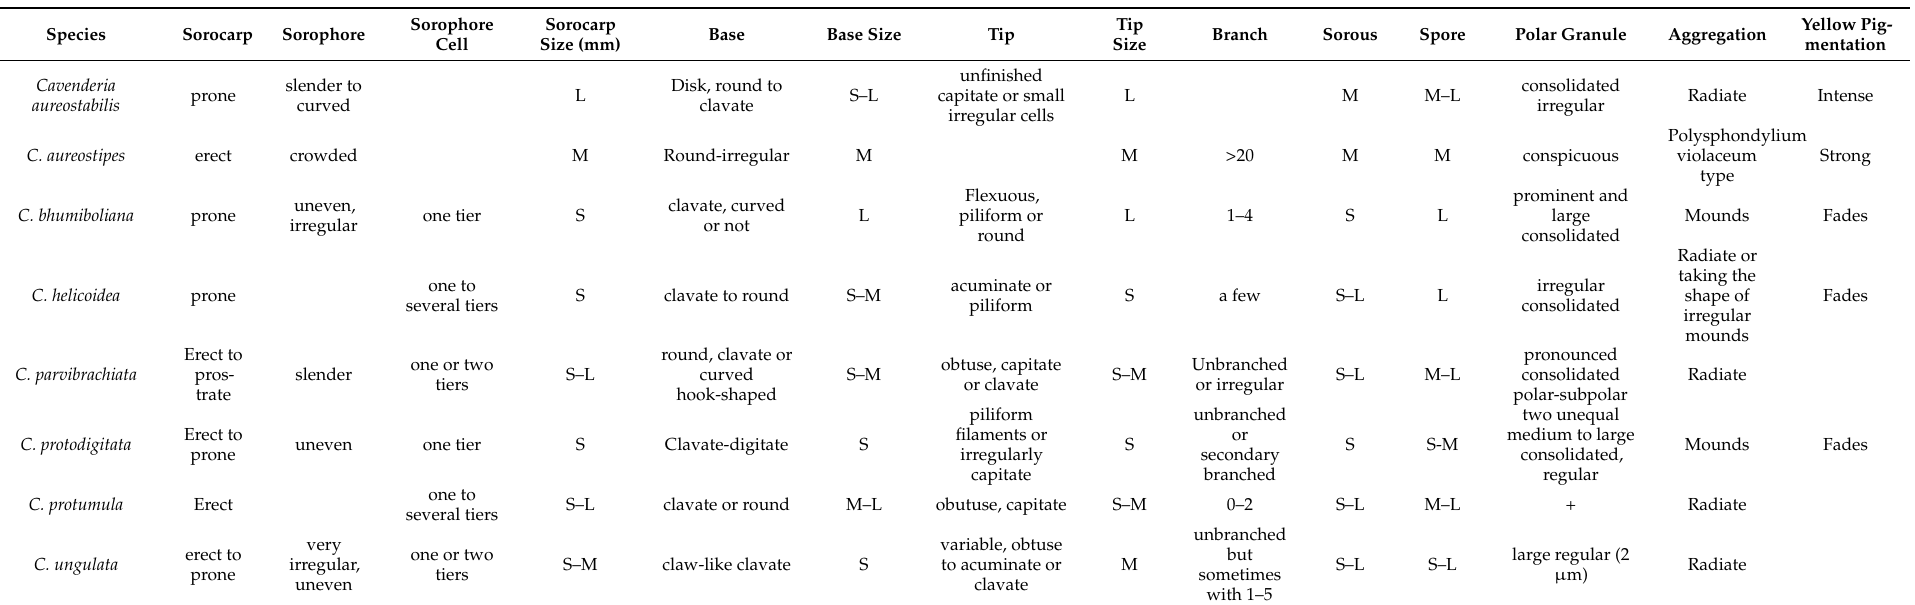
Table 2. Summary data on a comparison of the new species with closely related